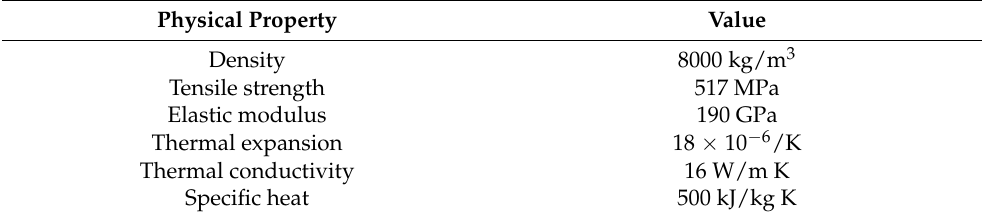
Table 2. Properties of stainless steel at 25 °C.